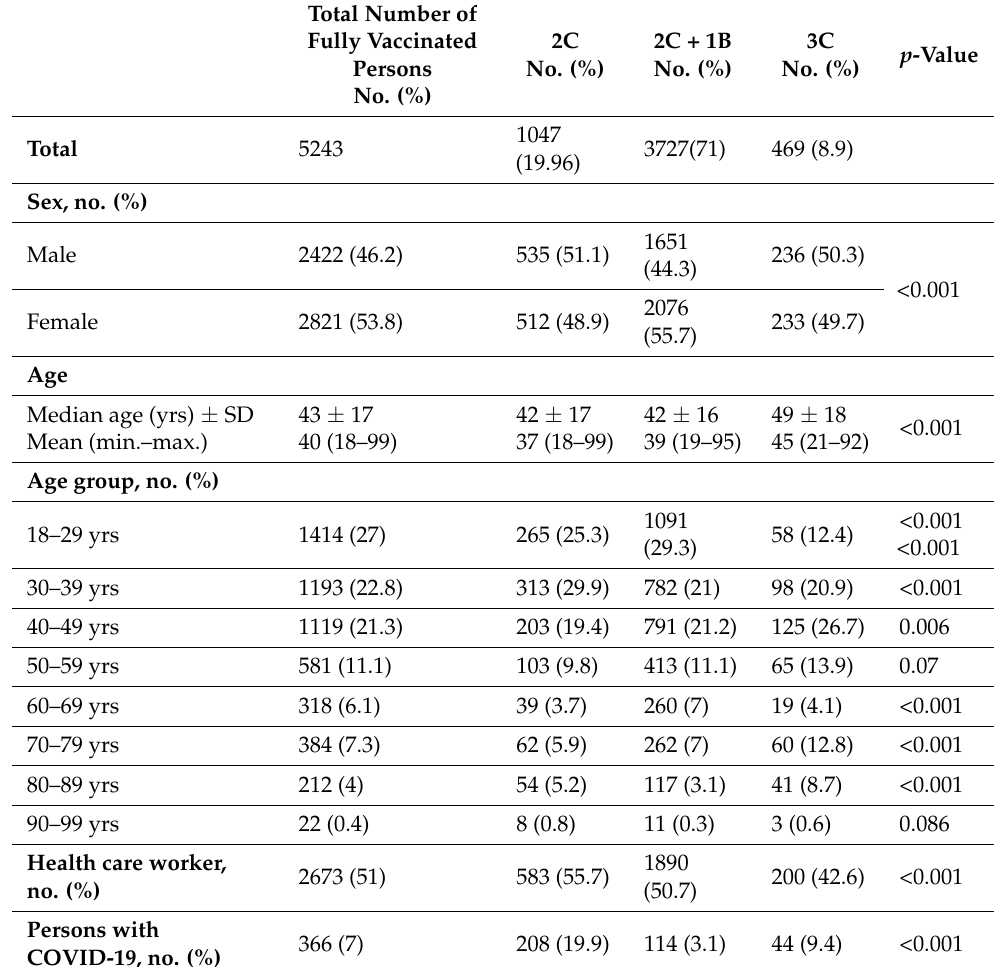
Table 1. Characteristics of study cohort categorized by vaccination status. Total Number of Fully